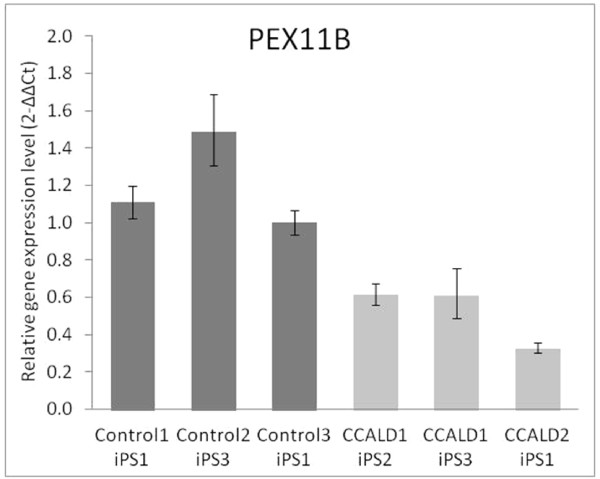
qRT-PCR confirmation of PEX11B gene expression in patient and healthy control iPSCs. Data from the analysis of PEX11B gene expression levels are provided. The error bars represent one standard deviation. The expression was lower in patients relative to control cells (two-tailed Student's t-test P-value < 0.5).